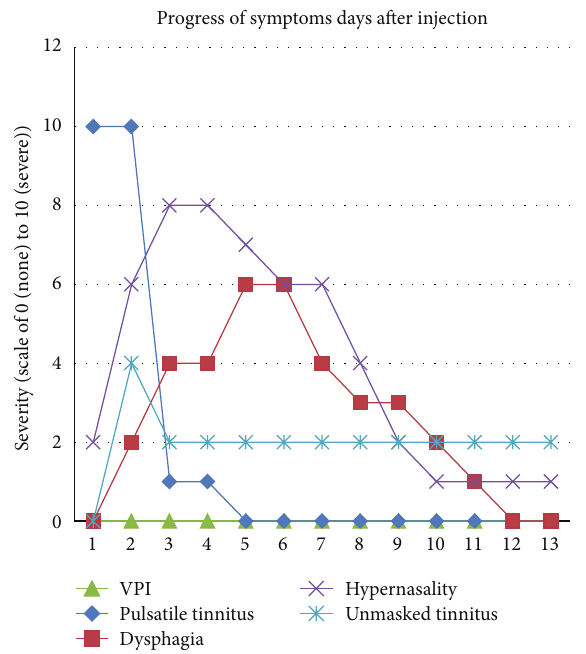
Figure 2: Progress of symptoms days after injection. Temporal onset and duration of symptoms over the course of 2 weeks after injection of 10.5 units of botulinum toxin into left tensor veli palatini. Temporal relationship of side effects of velopharyngeal insufficiency (VPI), dysphagia, hypernasality, and unmasking of tinnitus in contralateral ear is compared with symptomatic relief of pulsatile tinnitus in left ear (blue